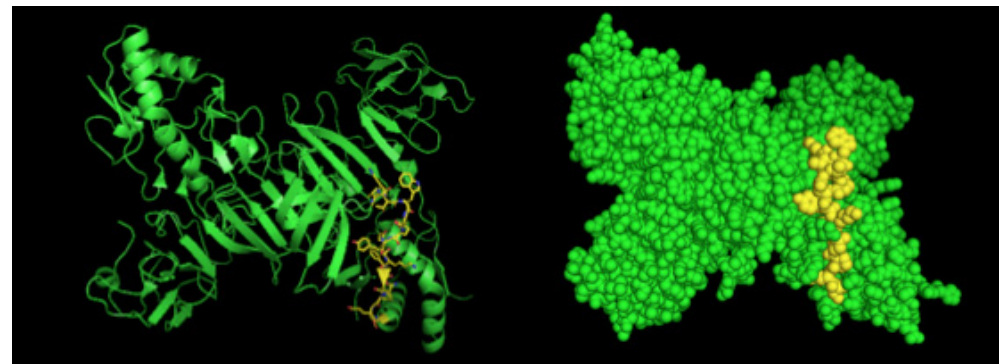
Figure 3. Three ‐ dimensional structural model of a NS1 dimer and regions corresponding to epitopes recognized by 4F6 mAb. The NS1 3D model was generated by the program Python Molecular (PyMOL) in green. The sequence 25 VHTWTEQYKFQPES 38 is highlighted in yellow.